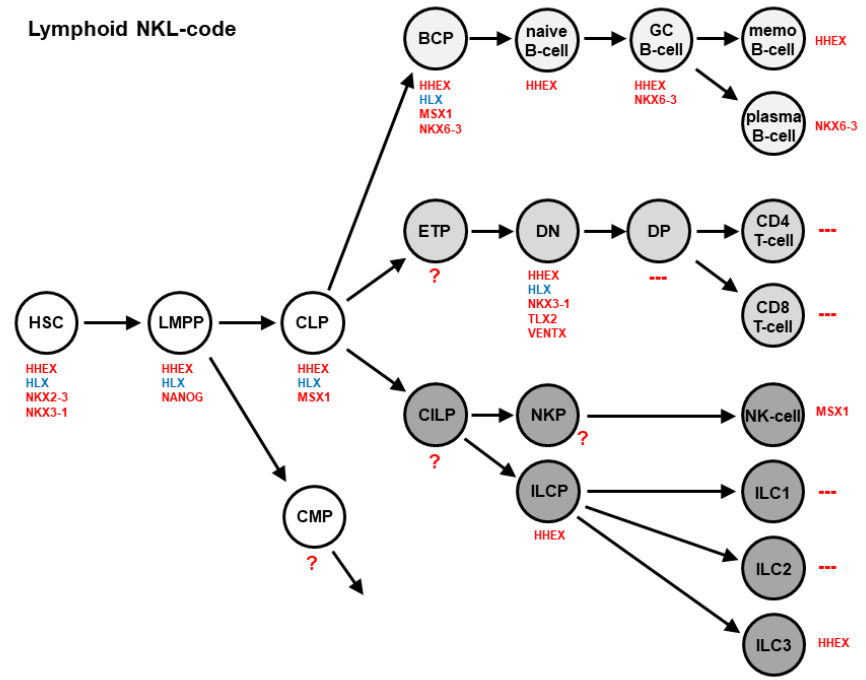
Figure 1. The lymphoid NKL-code describes activities of NKL homeobox genes (red) in stages and cell types of early hematopoiesis and lymphopoiesis, including developing B-cells, T-cells, NK-cells, and ILCs. NKL homeobox gene HLX is highlighted in blue. BCP: B-cell progenitor; CILP: Common innate lymphoid cell progenitor; CLP: Common lymphoid progenitor; CMP: Common myeloid progenitor; DN: Double negative thymocytes; DP: Double positive thymocytes; ETP: Early T-cell progenitor; GC: Germinal center; HSC: Hematopoietic stem cell; ILC: Innate lymphoid cells; LMPP: Lymphoid and myeloid primed progenitor; memo: Memory; NKP: NK-cell progenitor; ?: Cell types with unknown NKL gene activities; ---: Cell types with absent NKL gene activities.